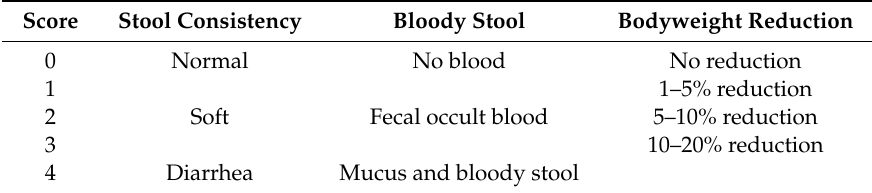
Table 2. Assessment of diarrhea, bloody stool, and bodyweight reduction in mice with DSS-induced colitis for calculation of total inflammation score.